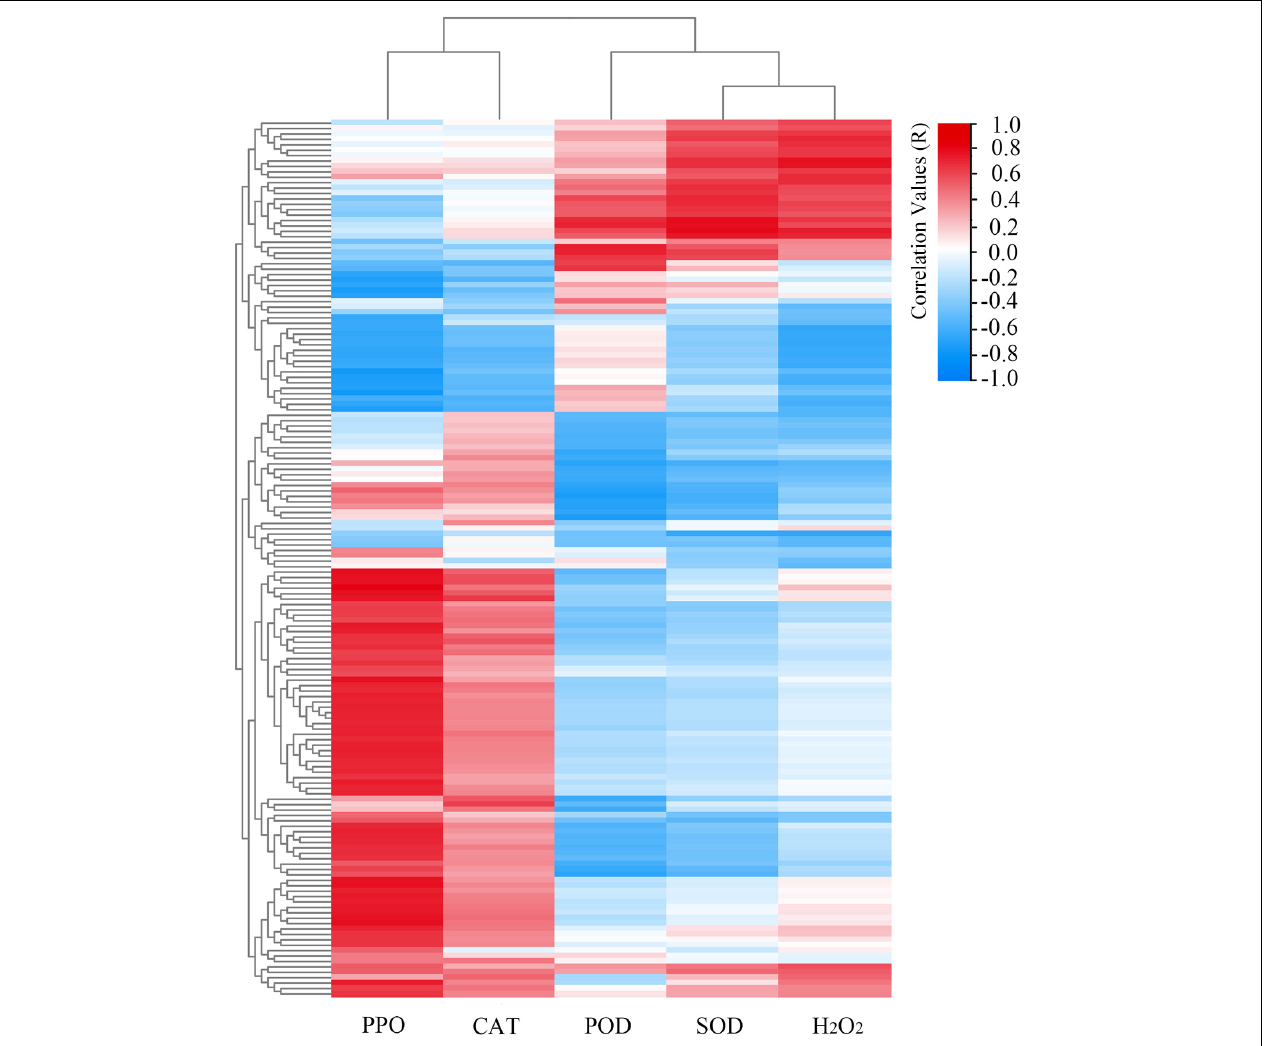
FIGURE 7 | Representative candidate genes of MAPK signaling pathway likely linked to the H 2 O 2 content and the main antioxidant enzyme activities (i.e., PPO, CAT, POD, and SOD). Scale bar represents the correlation values.